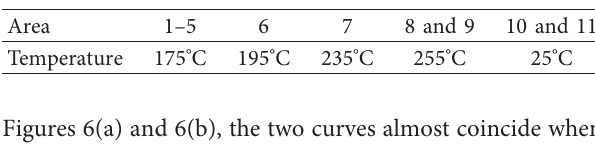
Figure 5: Flowchart of the dynamic Thomas algorithm, that is, forward elimination and backward substitution with time. Table 1: Set temperature of each